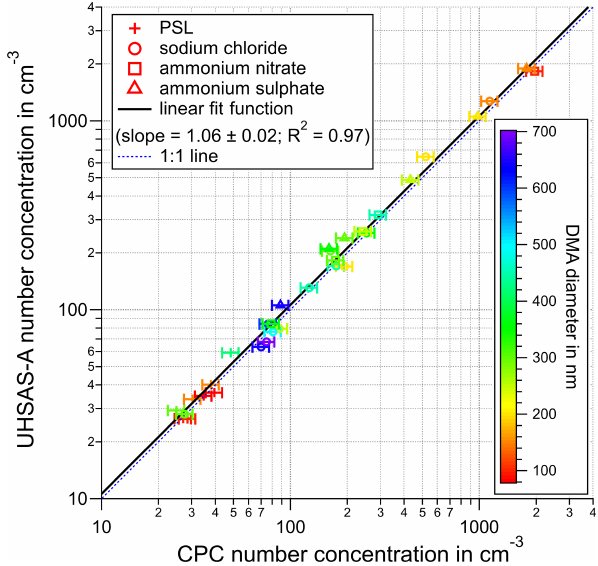
Figure A4. Characterization measurements of the counting effi- ciency of the UHSAS-A: comparison of the particle number con- centrations measured by the UHSAS-A and the TSI CPC 3025A reference for different particle species and particle sizes (color coded).